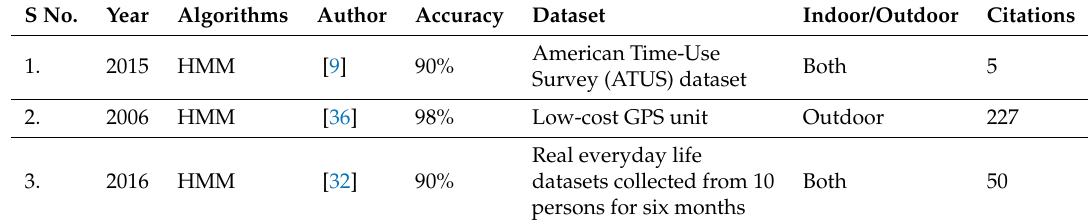
Table 3. Hidden Markov model.